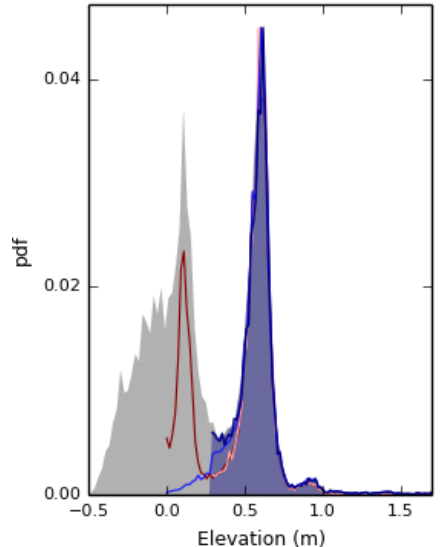
Figure 5. Diagram describing the elimination of the tail of the el- evation probability distribution function for site S1. The grey filled surface is the pdf of elevation for the original DEM. The dark red line is the pdf of elevation of the platform after the dispersion pro- cess. The orange line is the pdf of elevation of the platform after truncation of the tail of the distribution. The blue line is the pdf of elevation of the platform after filling pools and jagged outlines and after the addition of scarps in the platform ensemble. The dark blue line, associated to the blue filled surface, is the pdf of elevation for the final platform, after the tail of its distribution is truncated a sec- ond time. All distributions in this plot are forced to display the same maximum for clarity.